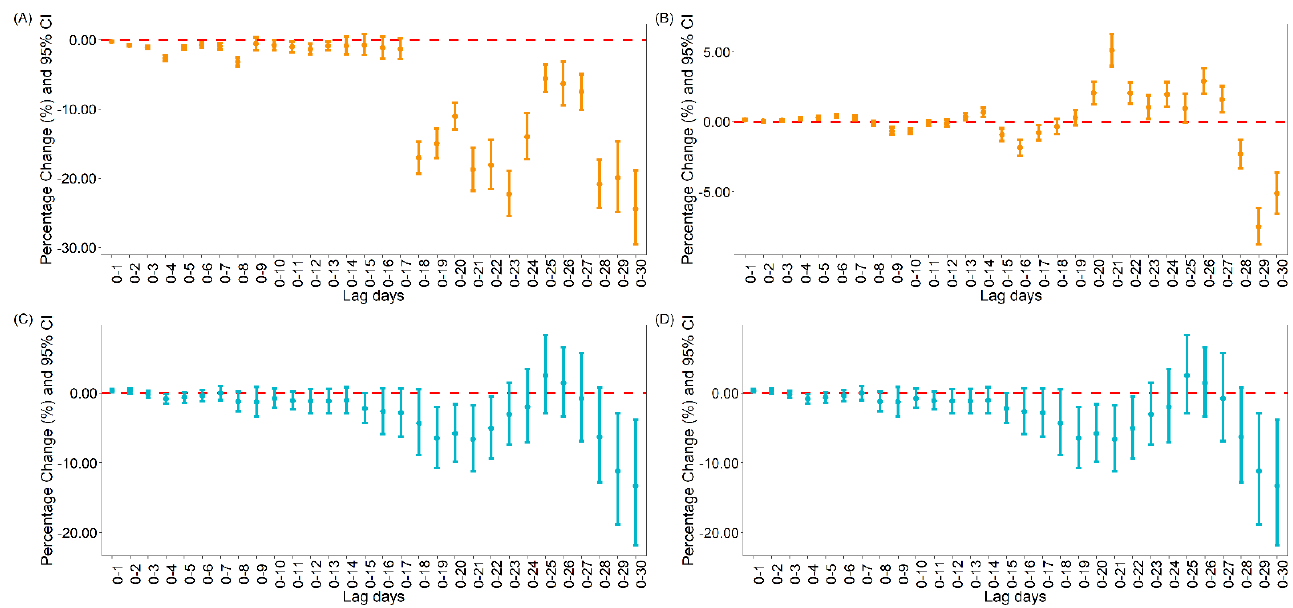
Figure 1. Percentage change of daily cases and deaths with moving lag globally. ( A ) Percentage change of daily cases with daily 10,000 people fully vaccinated increasing; ( B ) Percentage change of daily cases with daily 10,000 new people vaccinated increasing; ( C ) Percentage change of daily deaths with daily 10,000 people fully vaccinated increasing; ( D ) Percentage change of daily deaths with daily 10,000 people vaccinated increasing.